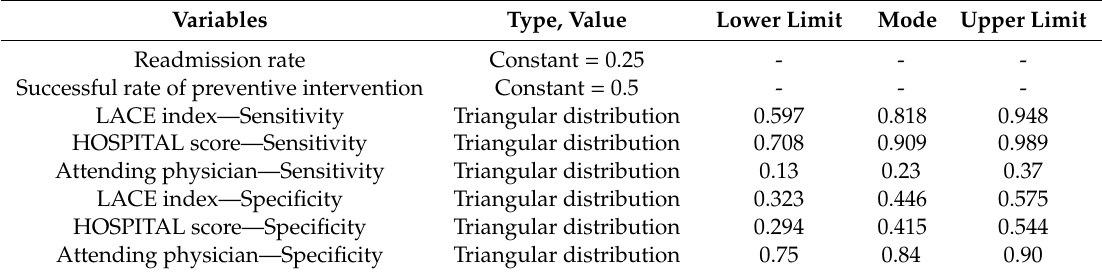
Table A2. Summary of variables and key parameters used in the microsimulation